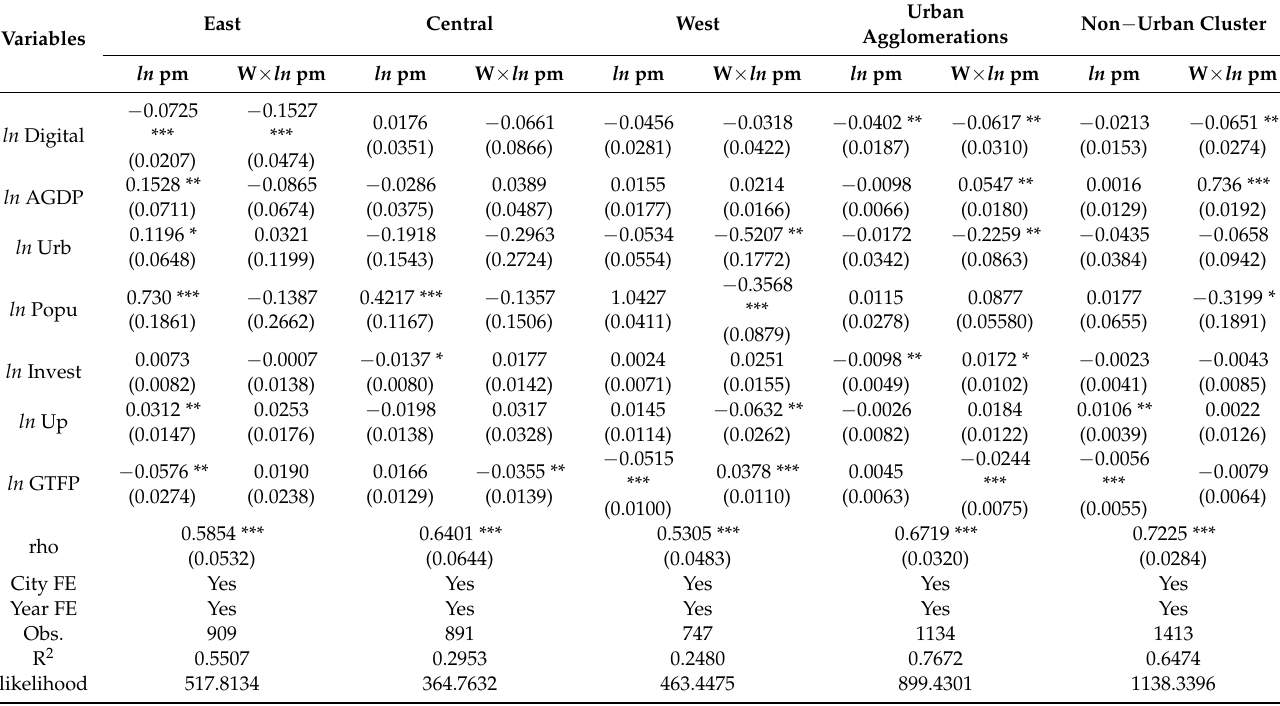
Table 9. Regression results for the spatial heterogeneity